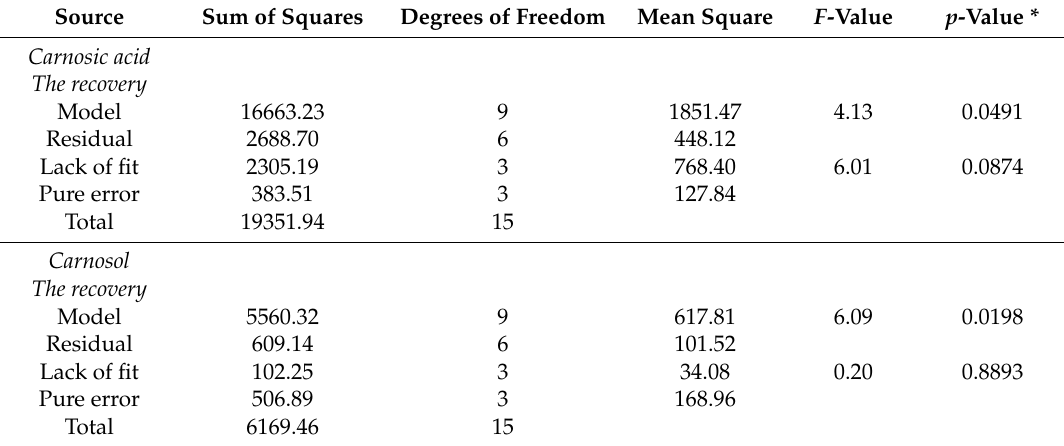
Table 4. Analysis of variance (ANOVA) of the modeled